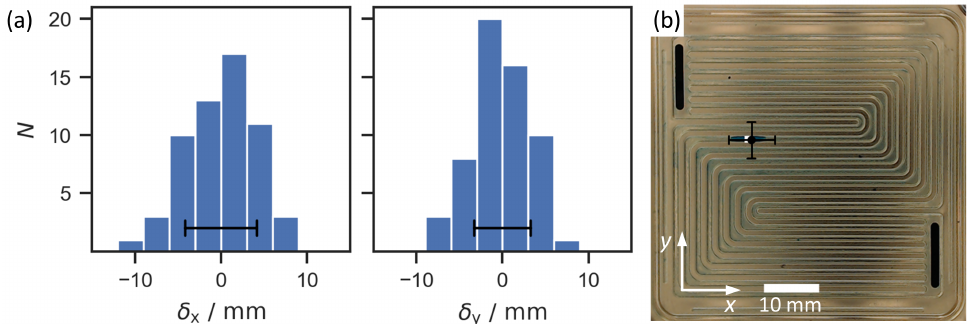
Figure 9. ( a ) Histograms showing the frequency distribution of the differences δ x and δ y between the estimated and true x and y coordinates for the test cases. ( b ) Flow field with the true (white square) and predicted (black circle) positions of the water drop for one measurement. The error bars mark double the empirical standard deviation in all